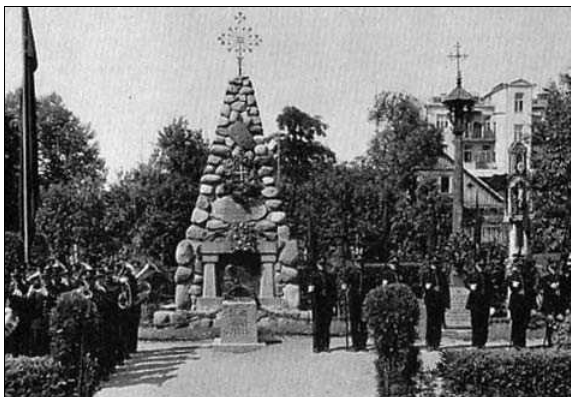
Fig. 4. Monument to the Fallen for Independence in